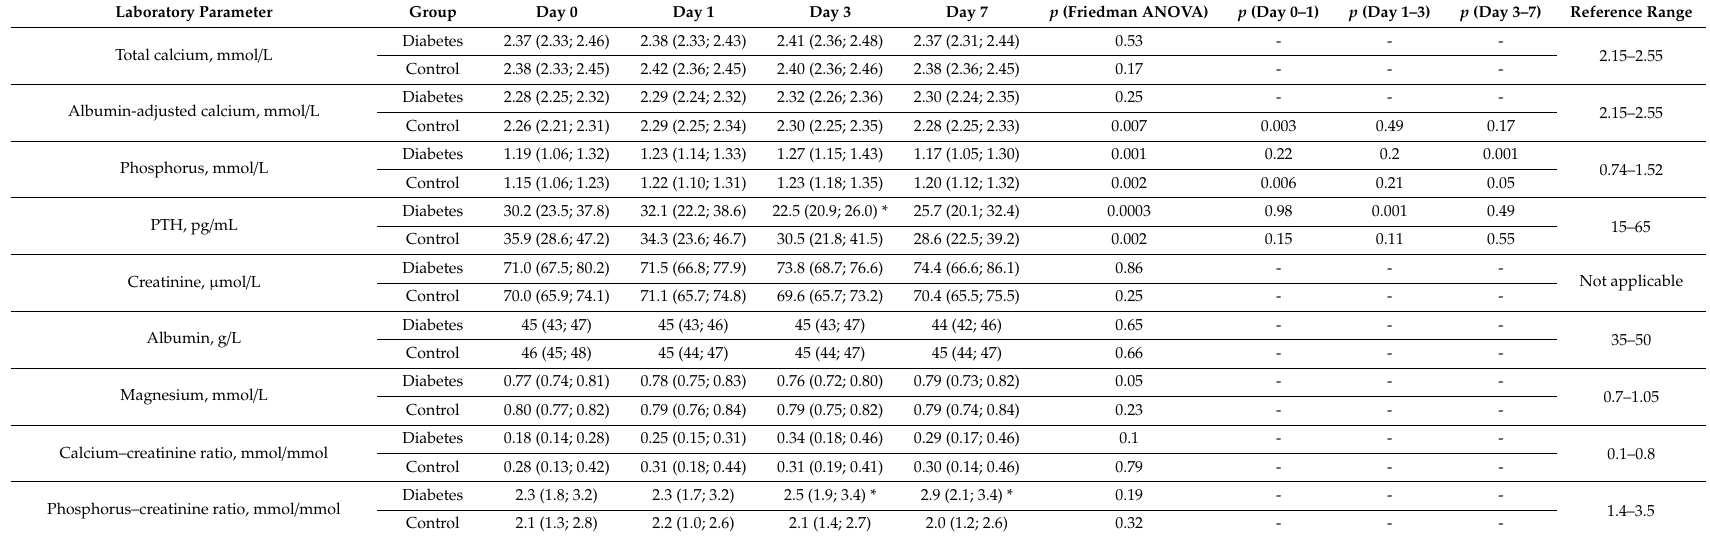
Table 4. Changes in the levels of the biochemical parameters and parathyroid hormone (PTH) during the